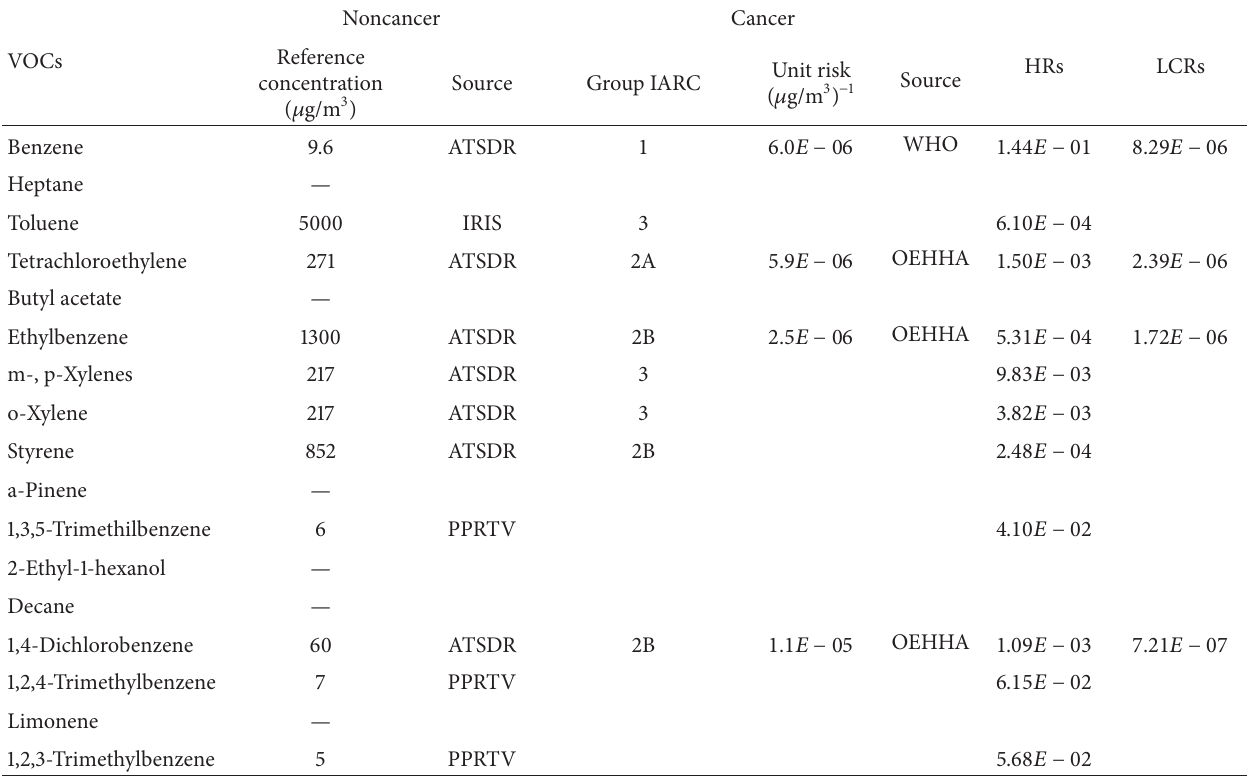
Table 5: Noncancer reference concentrations. cancer unit risks of the VOCs found during the monitoring campaign and their carcinogenic classifications in the IARC. The mean hazard ratio (HR) and the lifetime cancer risk (LCR) of each compound was calculated. Noncancer Cancer Reference VOCs Unit risk Source Group IARC concentration ( 𝜇 g/m 3 ) − 1 ( 𝜇 g/m 3 ) Benzene 9.6